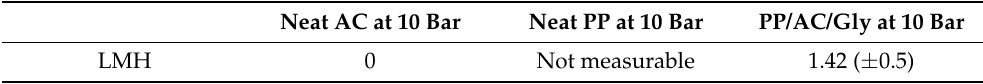
Table 1. Water flux data of separators. Neat AC at 10 Bar Neat PP at 10 Bar PP/AC/Gly at 10